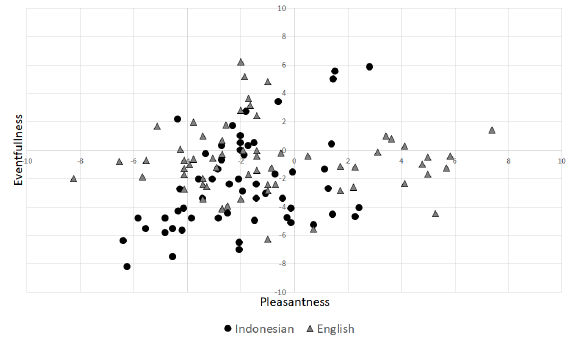
Fig. 5. Soundscape dimensions score from English and Indonesian